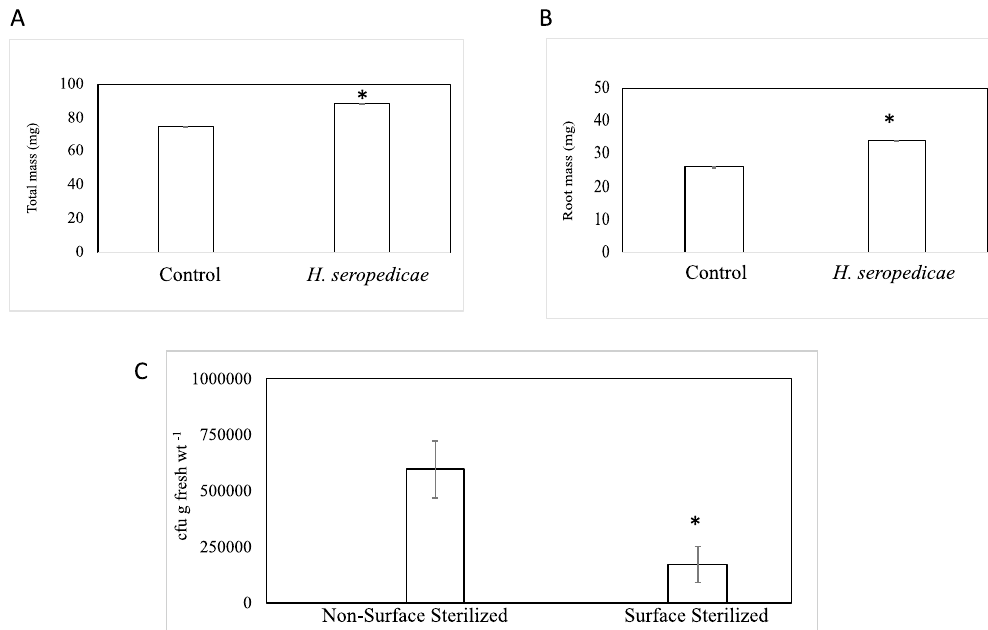
Figure 1. Growth promotion and root colonization in wild-type rice plants by H. seropedicae . ( A ) Shows that the total plant mass of wild-type rice plants increased significantly upon inoculation with H. seropedicae . Asterisk (*) denotes a significant difference between the two treatments by t -test ( P < 0.002). Data represent the average of three experimental replications (n = 15) ± SE. ( B ) Shows that the root mass of wild-type rice plants increased significantly upon inoculation with H. seropedicae. Asterisk (*) denotes a significant difference between the two treatments by t -test ( P < 0.01). Data represent the average of three experimental replications (n = 15) ± SE. ( C ) Shows a comparison of total colony-forming units (cfu) of H. seropedicae determined by serial dilution and plate counts of bacteria between non-surface sterilized and surface-sterilized roots of wild-type rice seedlings inoculated with H. seropedicae . The data are an average of three experiments. Each experiment had at least three plants. Asterisk (*) denotes a significance between the conditions by t -test ( P <